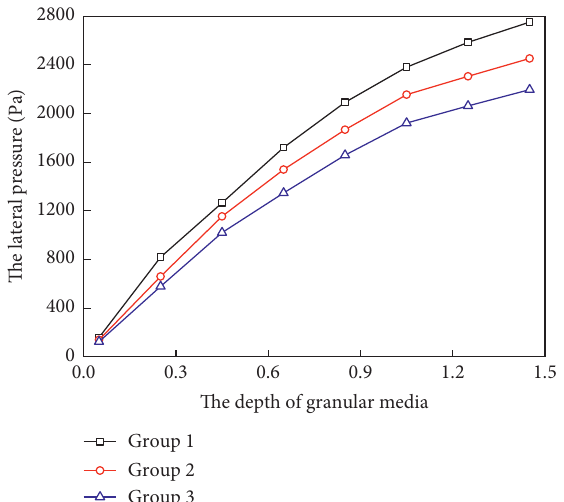
Figure 3: The relationship between the lateral pressure and depth of granular media under the limiting equilibrium state.